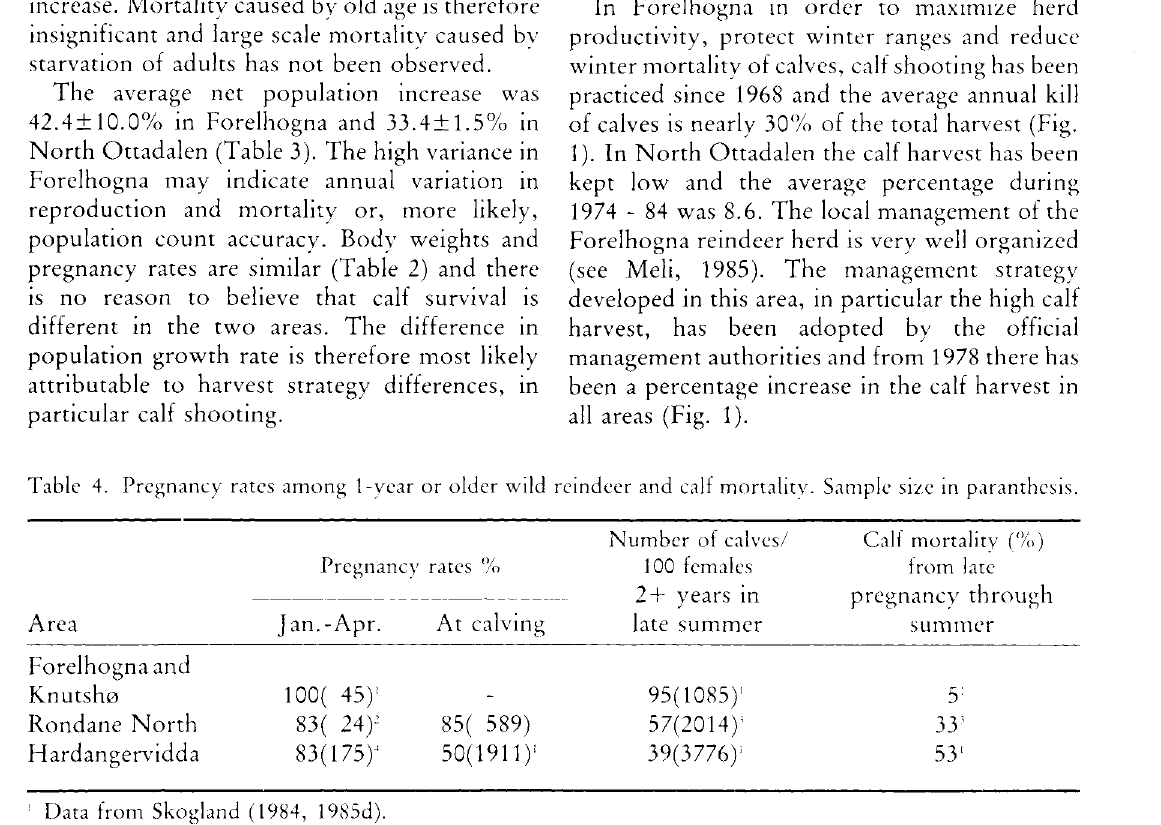
Fig. 1. Harvest of wild reindeer calves from 1975.